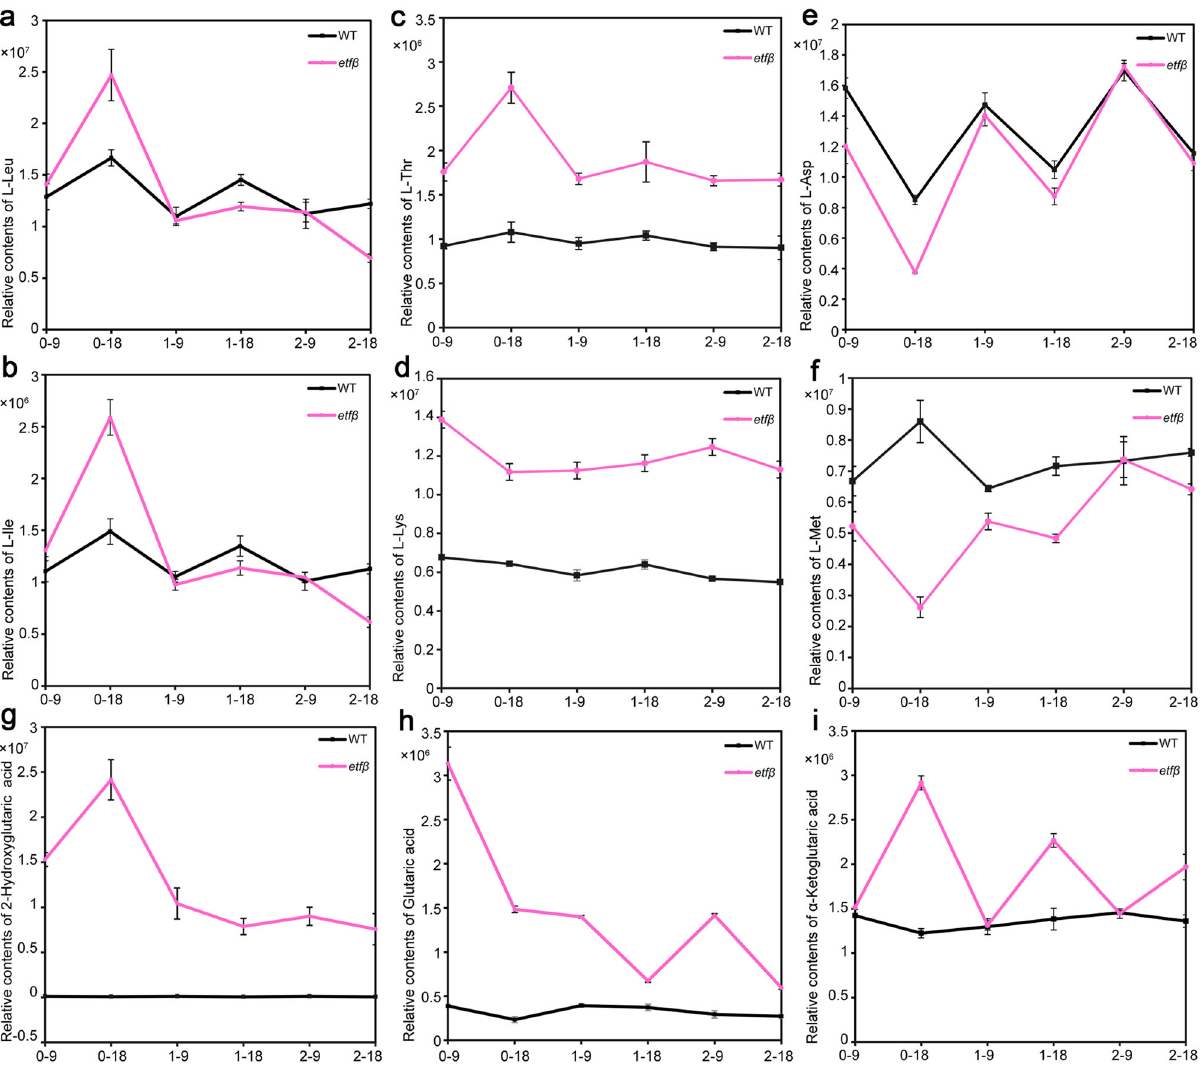
Fig. 6 Nitrogen de fi ciency resulting from metabolic abnormalities in etf β can be rescued by increasing exogenous N. a – f Relative contents of L-Leu, L-Ile, L-Thr, L-Lys, L-Asp, and L-Met in wild type (WT) and etf β under three N concentrations and two developmental stages. The numbers on the X -axis, such as 0 – 9, 0 – 18, 1 – 9, 1 – 18, 2 – 9 and 2 – 18, indicate the corresponding N concentrations (0: N free, 1: 1 N, and 2: 2 N) and developmental stages (9 and 18cm panicles in length). Error bars indicate standard deviation of three independent biological replicates. g – i Relative contents of glutaric acid, 2-hydroxyglutaric acid, and α -ketoglutaric acid in WT and etf β under three N concentrations and two developmental stages. Error bars indicate standard deviation (SD) of three independent biological replicates. Source data are provided in the Source Data fi